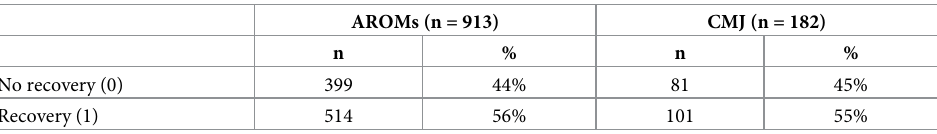
Abbreviations: AROM, athlete-reported outcome measures; CMJ, countermovement